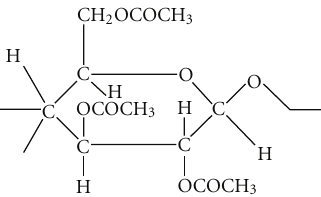
Figure 1: The structural formula of CTA. CTA is formed by sub- stituting three hydroxyls within cellulose.